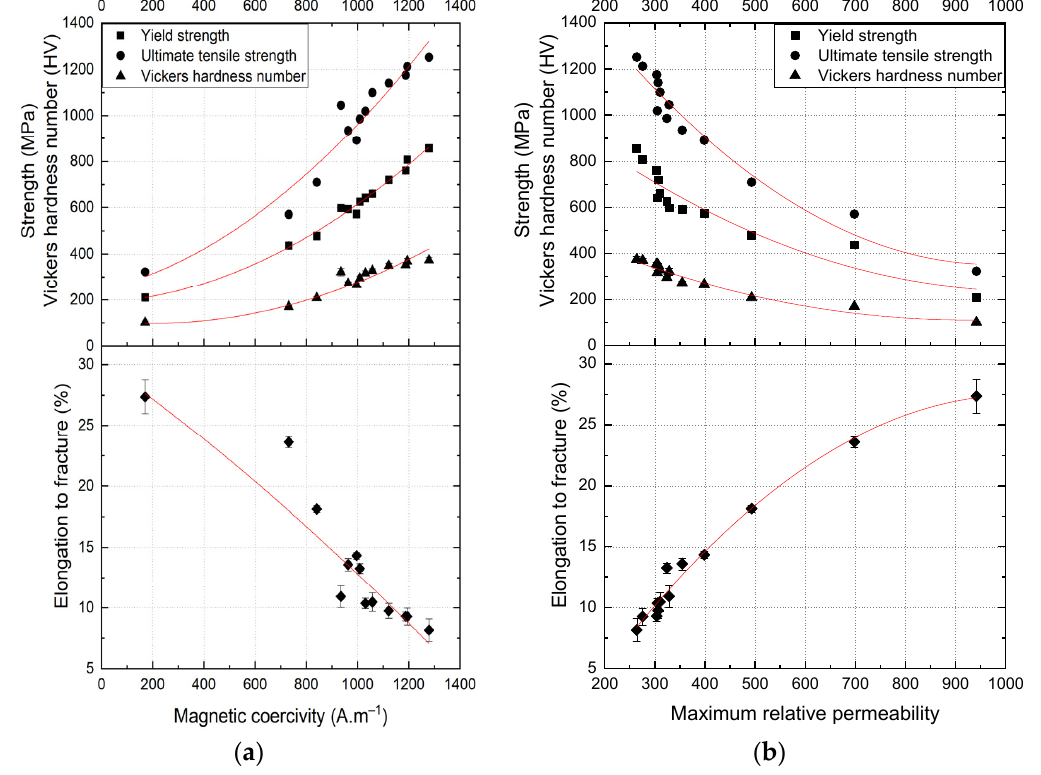
Figure 8. Correlations between ( a ) coercivity and ( b ) maximum relative permeability with the tensile properties and Vickers hardness of carbon steels of groups A and B.